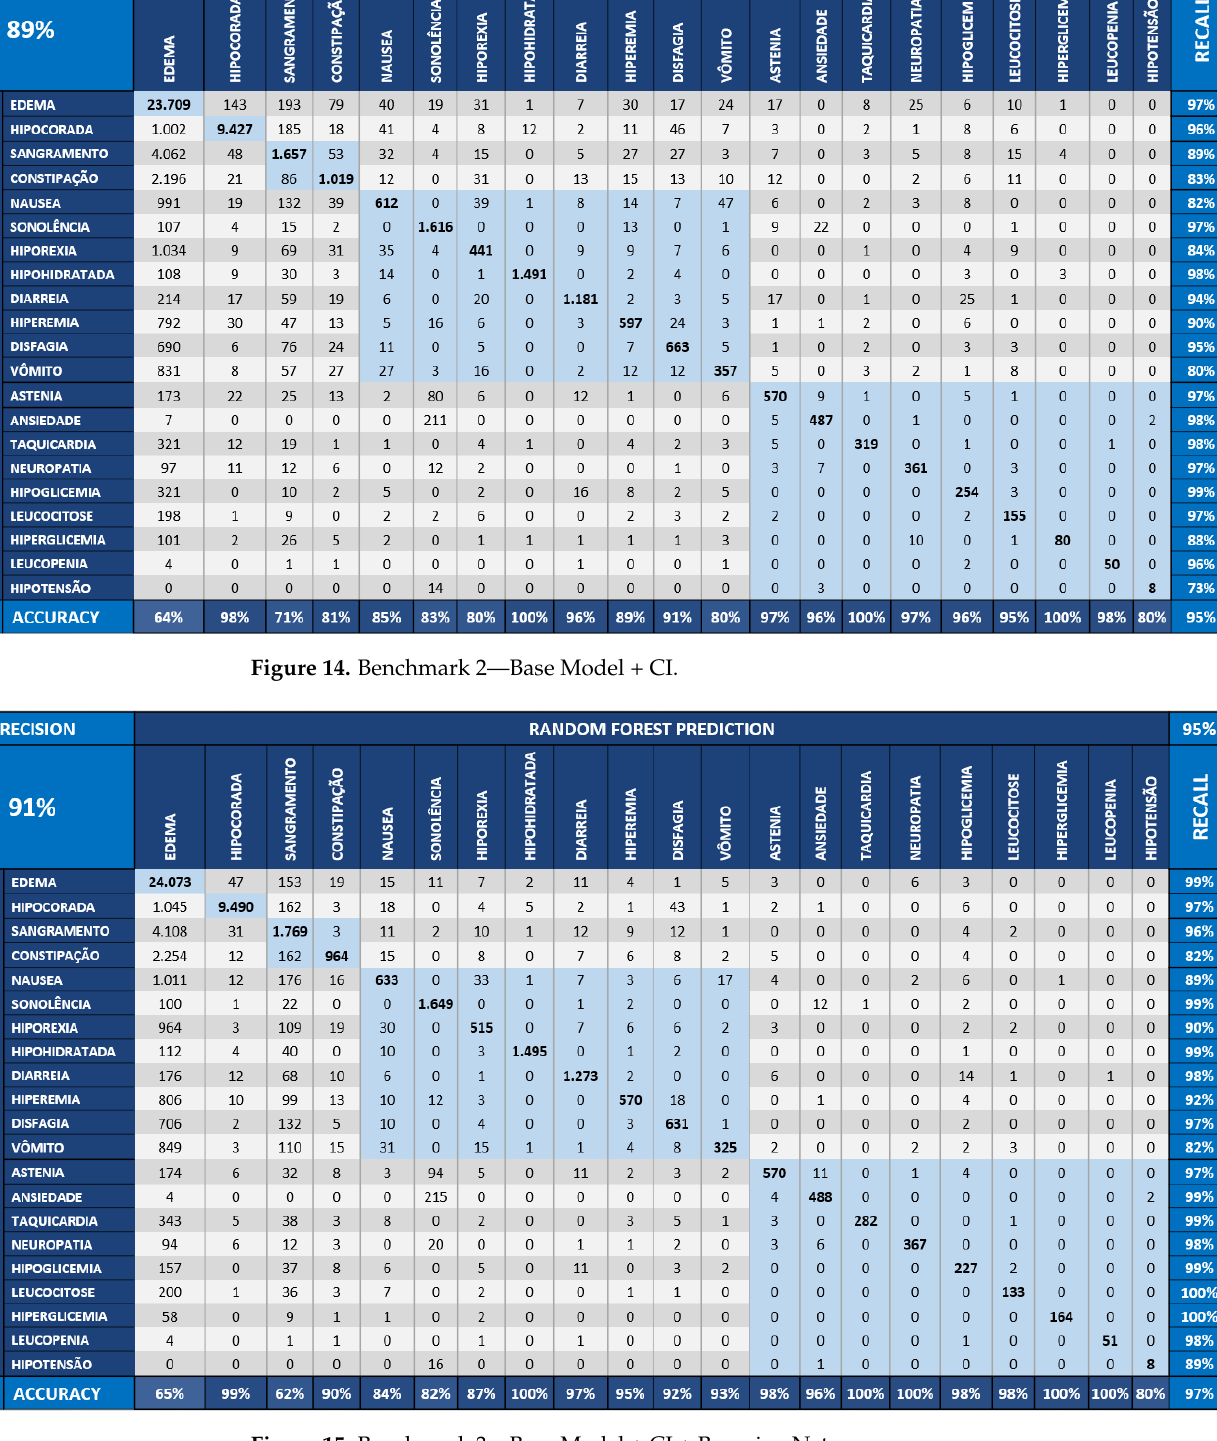
Figure 15. Benchmark 3—Base Model + CI + Bayesian